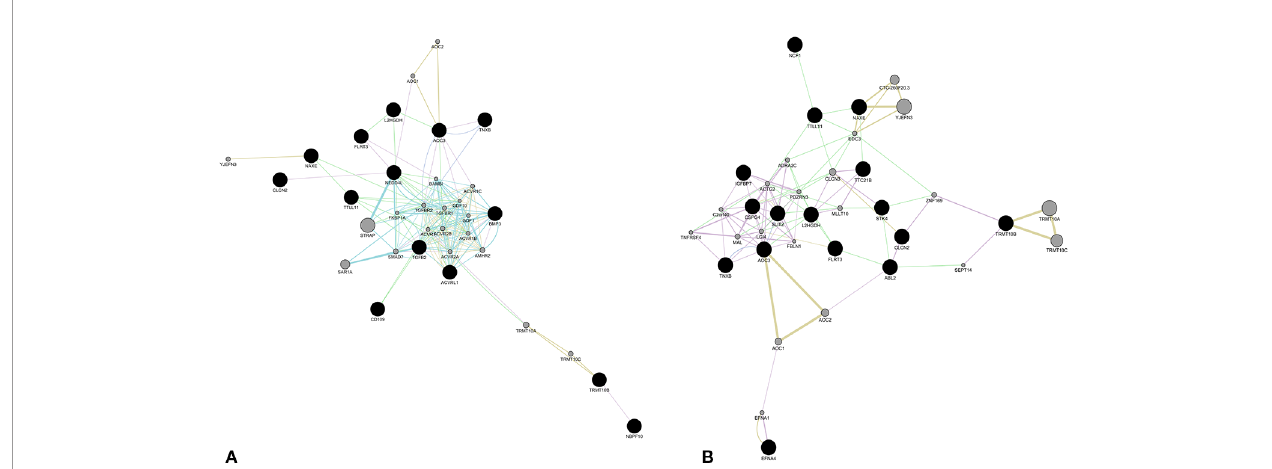
FIGURE 2 | Molecular network obtained by GeneMania plugin (Cytoscape). The network shows patterns of co-expression (violet), co-localization (blue), genetic interaction (green), pathway (light blue), predicted interaction (orange), and shared proteins domains (yellow), obtained from merger of genes affecting by likely gene- disrupting (LGD) variants. The eight novel loci were merged with those involved in TGF b signaling (A) and those involved in angiogenesis and vessel differentiation (B) . Color of each edge is in relation of the kind of interaction. Black nodes represent input genes. Gray nodes resulted from analysis. Details about nodes and edges as well as annotations are available in Tables 1 – 5, supplied in Supplementary Materials SM3